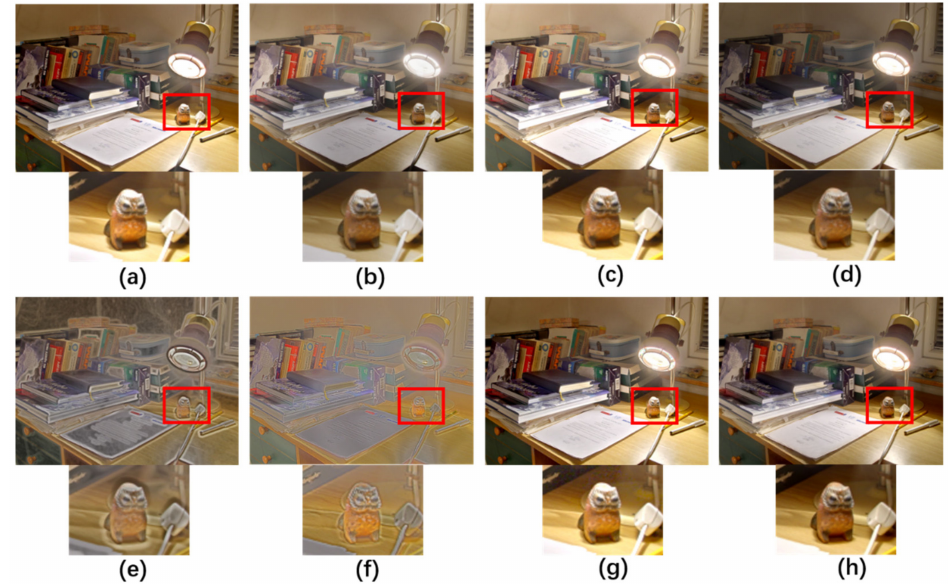
Figure 10. Comparison of fusion results for Figure 9a. ( a ) SPD-MEF method fusion result. ( b ) MRF method fusion result. ( c ) DSIFT method fusion result. ( d ) FEAF method fusion result. ( e ) LE method fusion result. ( f ) B-LP method fusion result. ( g ) LLF method fusion result. ( h ) The proposed method